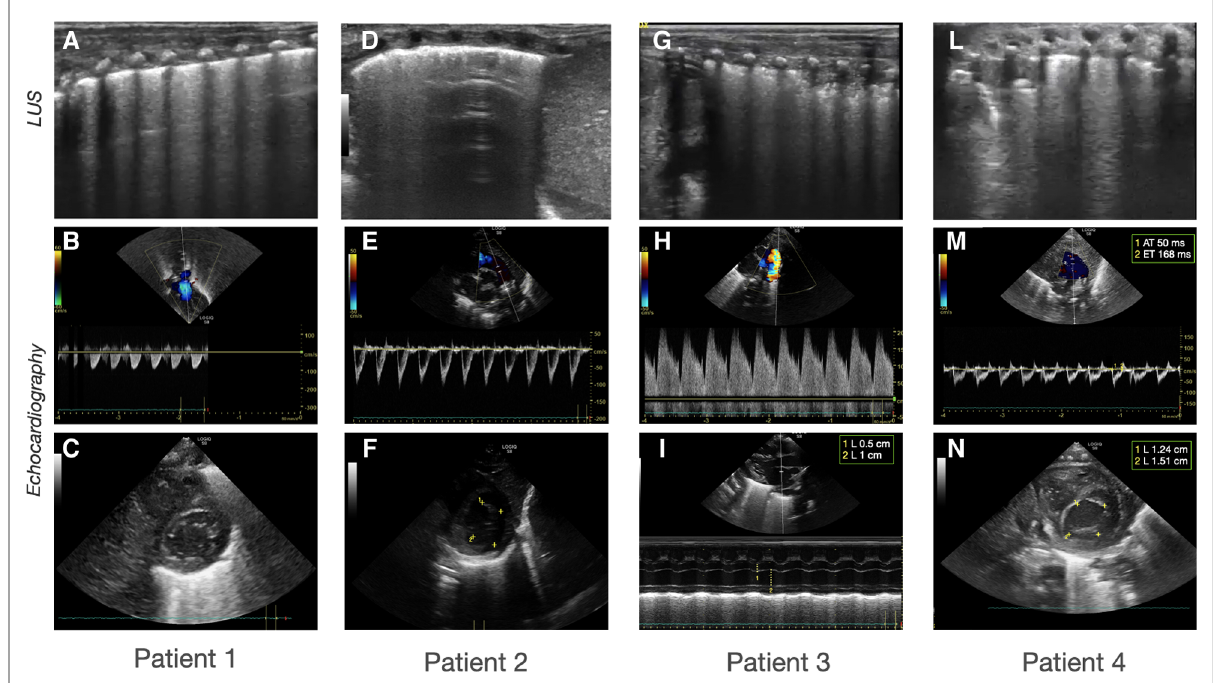
FIGURE 2 Histological examination of the placentas. Representative pictures of the histological examination of the placenta. H & E 5×: Hematoxylin and eosin stain at 5 magni fi cations; H & E 10×: Hematoxylin and eosin stain at 10 magni fi cation; IHC-CD34: Immunohistochemistry stains for cluster of differentiation. ( A-C ) Case 1: ( A ) H & E showing normal placenta for the gestational age with mild signs of chorioamnionitis; ( B ) H & E showing absence of vasculitis; ( C ) IHC showing normal distribution of CD34 in the placental vessels. ( D-F ) Case 2 : ( D ) H & E stain showing severe chorioamnionitis; ( E ) H & E stain showing severe vasculitis; ( F ) IHC showing normal distribution of CD34 in the placental vessels. ( G-I ) Case 3 : ( G ) H & E showing normal placenta for the gestational age with mild signs of chorioamnionitis; ( H ) H & E showing absence of vasculitis; ( I ) IHC showing normal distribution of CD34 in the placental vessels; ( L-N ) Case 4 : ( L ) H & E showing severe chorioamnionitis and acute ischemic area of malperfusion; ( M ) H & E stain showing severe vasculitis and funisitis; ( N ) IHC showing severe suppression of CD34